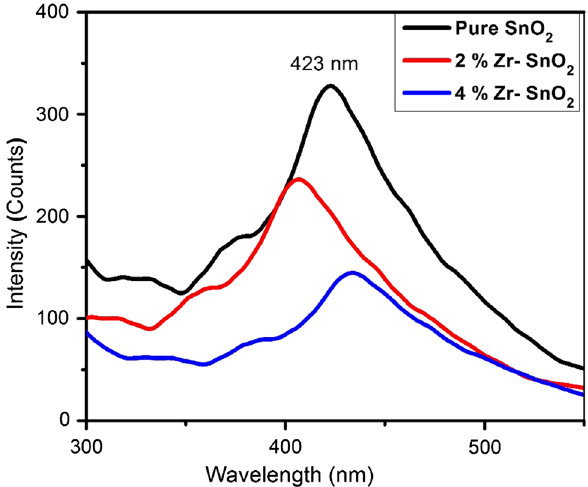
Fig. 6 PL spectra of SnO SnO